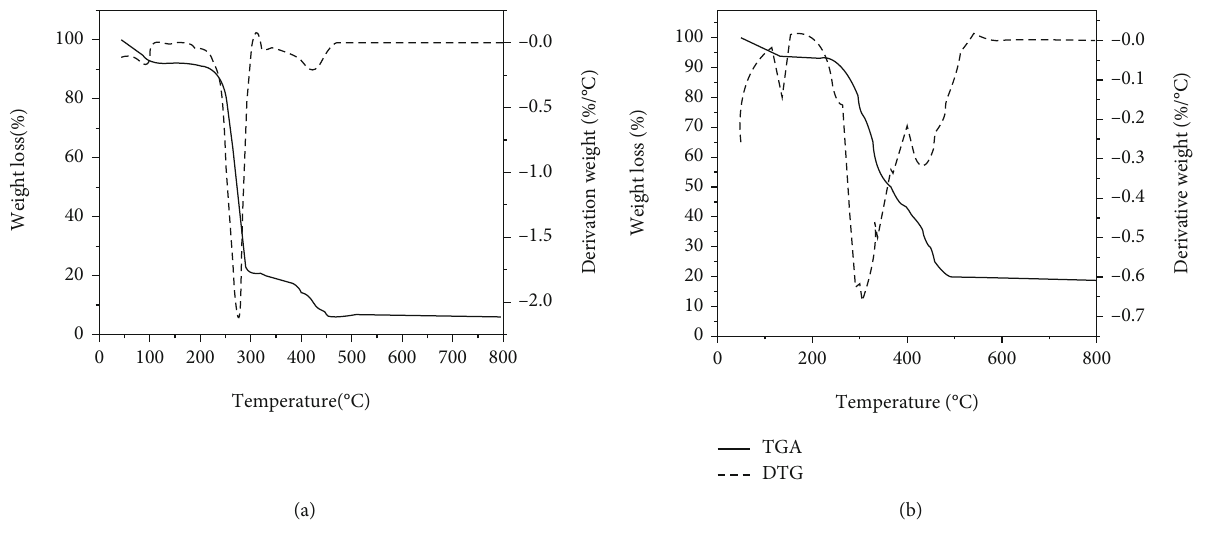
Figure 2: DTG/TGA diagram of coir (a) and rice husk